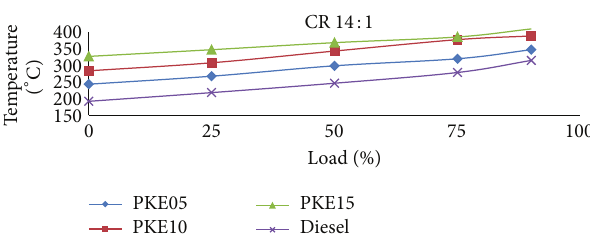
Figure 7: Load versus exhaust gas temperature at 14: 1